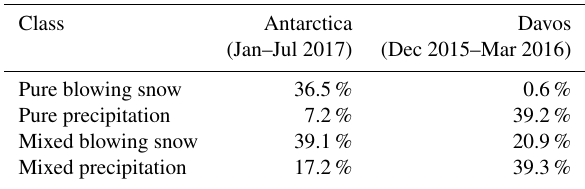
Table 3. Percentages of MASC images per